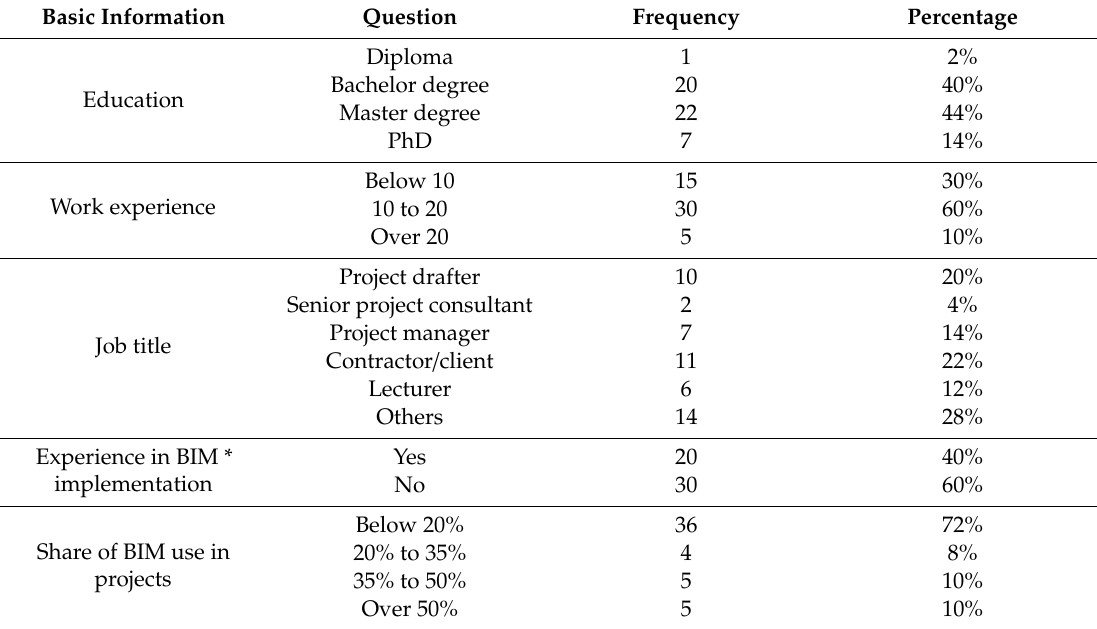
Table 2. Respondent